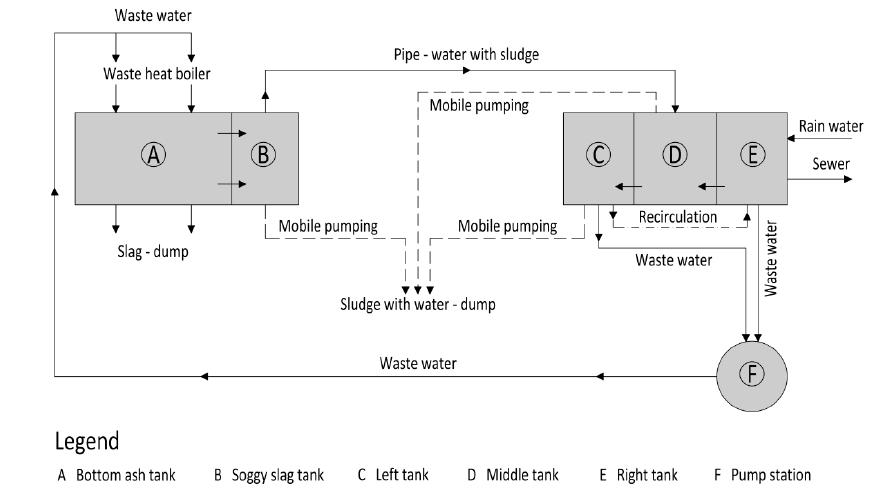
Figure 1. Existing SM scheme at the